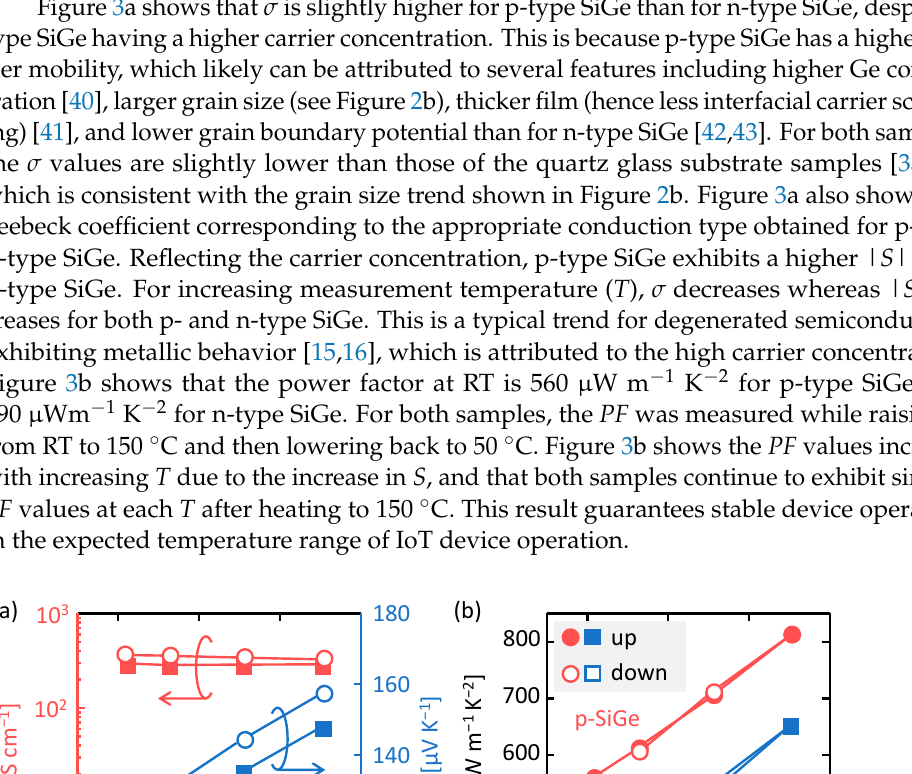
Figure 2. Characteristics of the p- and n-type samples formed by LE using Al and Ag:As, where metal layers were removed. ( a ) Raman spectra and ( b ) SEM (70° tilted) and inverse pole figure im- ages, where colors indicate crystal orientation as shown by color key.